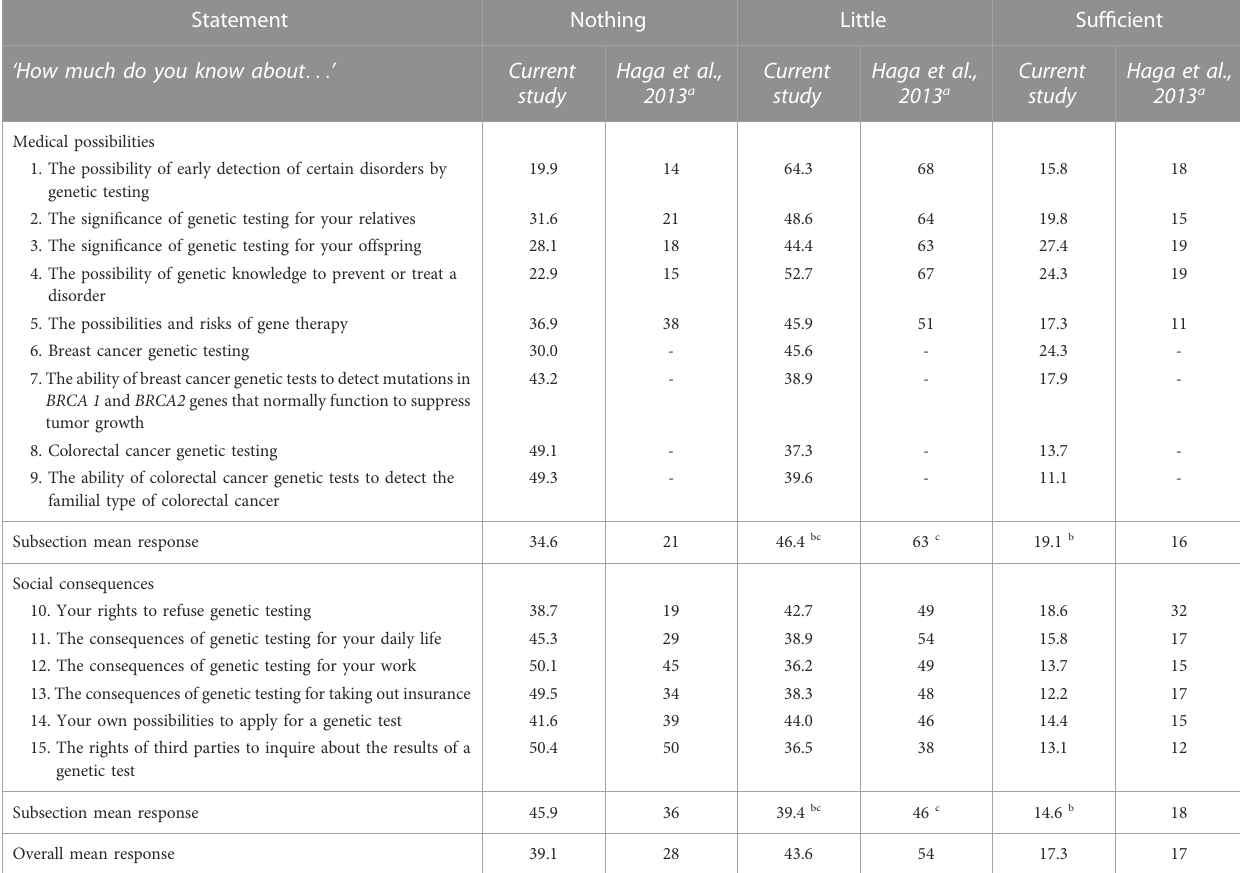
TABLE 5 Participants ’ percentage response pertaining to perceived knowledge of genetics.